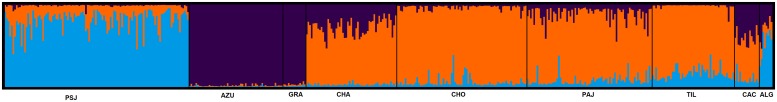
Bayesian STRUCTURE of the Humboldt penguin, delta K = 3, using admixture model.1- Punta San Juan; 2- Isla Pan de Azucar; 3- Isla Grande de Atacama; 4- Chañaral; 5- Choros; 6- Pájaros; 7- Tilgo; 8- Cachagua; 9- Algarrobo; 10- Pupuya; 11- Chiloé.